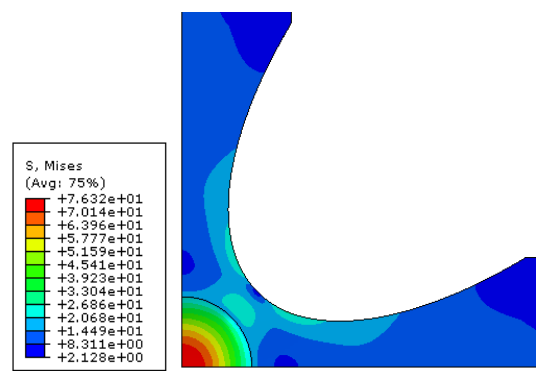
Figure 8: Stress distribution in the optimized geometry, t=5mm, Load Case 2.